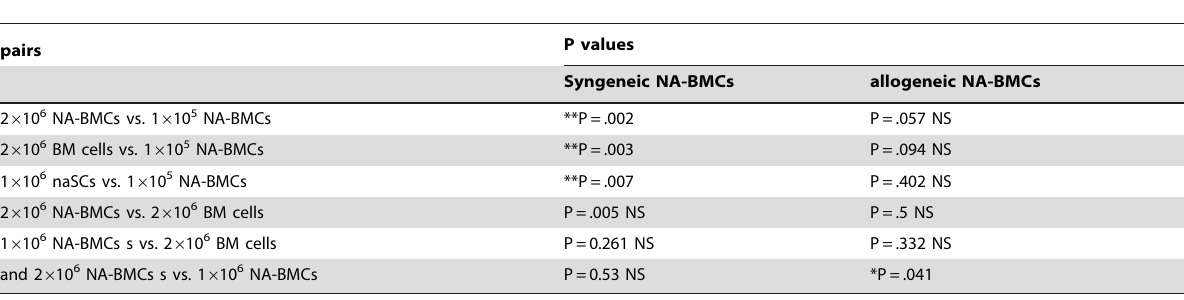
Table 1. P values after syngeneic and allogeneic transplantation.